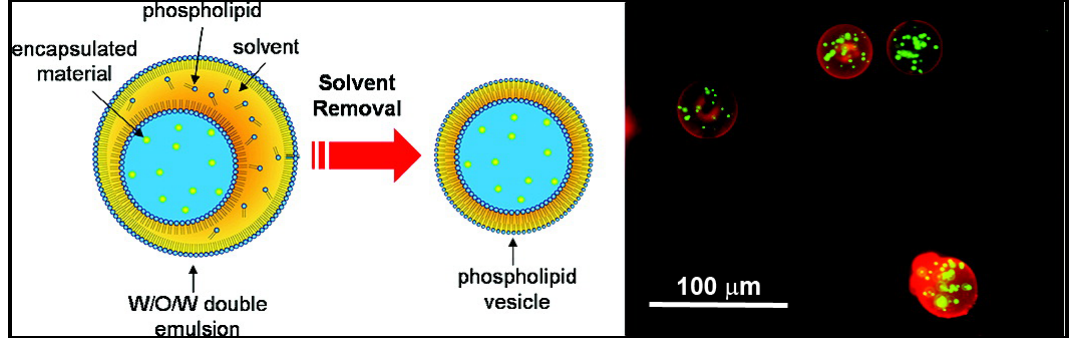
Figure 7. Schematic representation of the preparation of phospholipid vesicles using double emulsion ( left ) and fluorescent optical micrograph ( right ) of latex microspheres (green) encapsulated inside DPPC vesicles (red). Reprinted with permission from Shum et al. [120], Copyright (2008) American Chemical